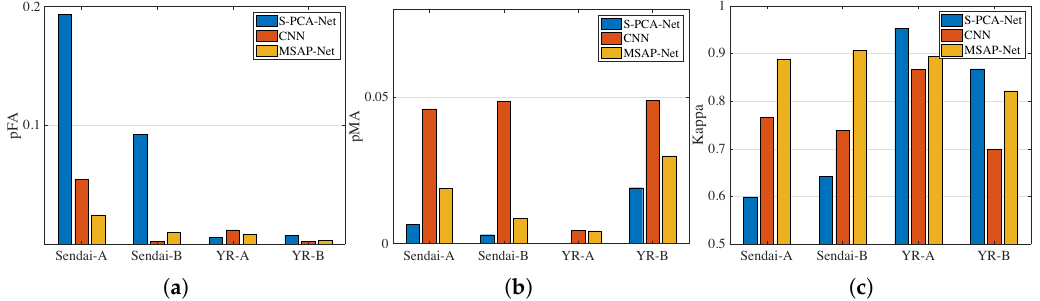
Figure 6. The comparisons of quantitative evaluations in terms of ( a ) FA, ( b ) MA and ( c ) Kappa